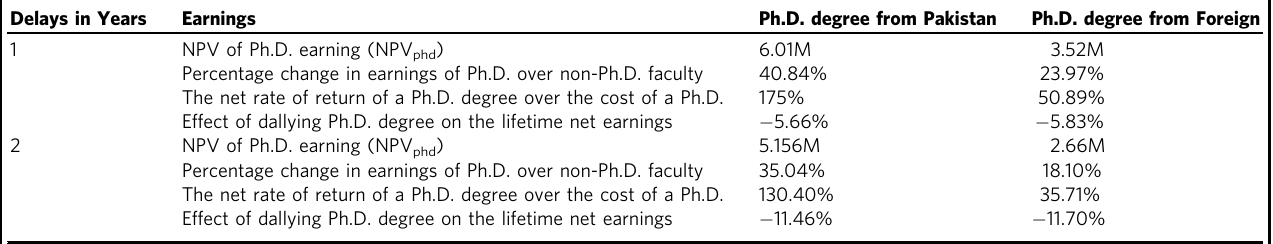
Table 11 Effect of delay in completion of the Ph.D. degree on NPV of earnings. Delays in